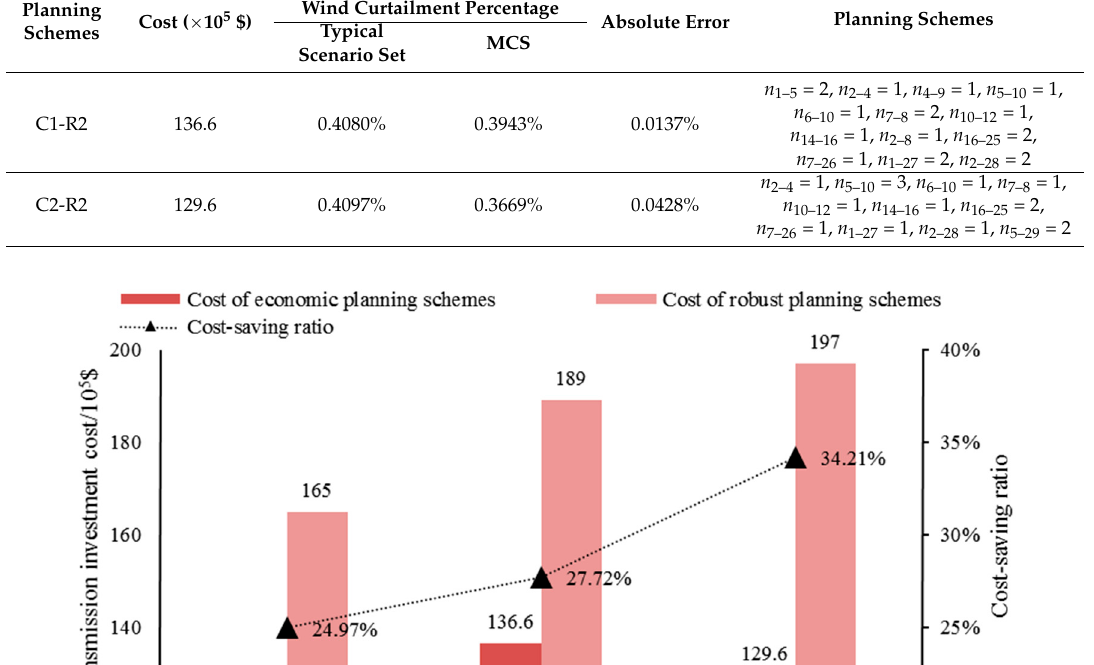
Table 6. Two economic planning schemes, C1 and C2.